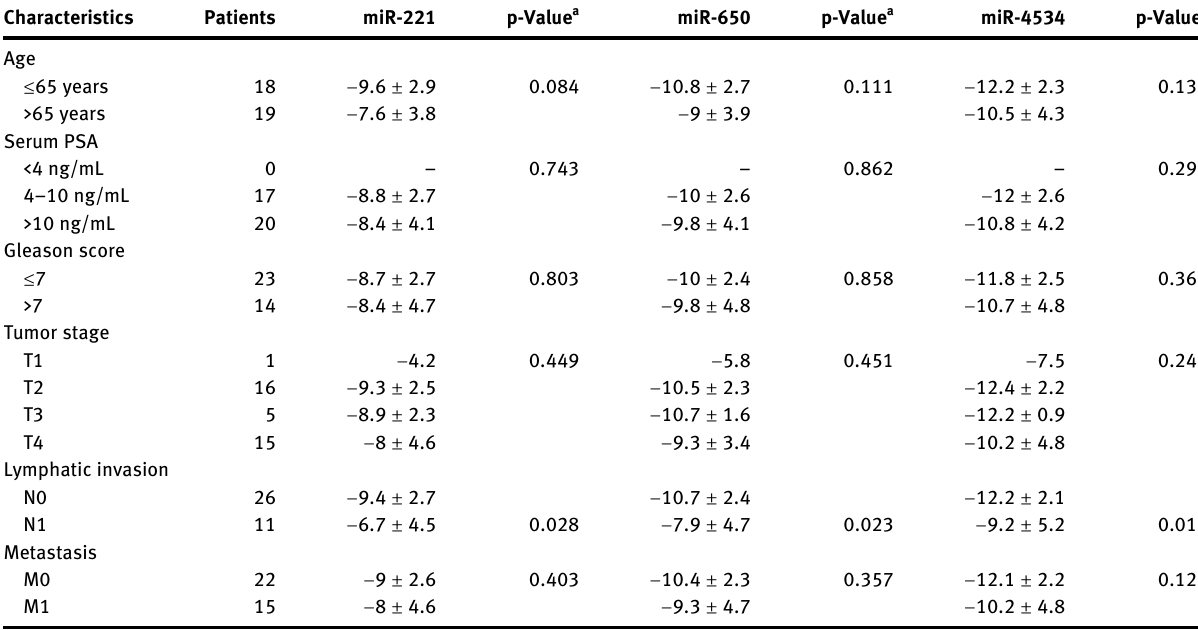
Table  : Relationship between clinical characteristics and miRNA expression levels of PCa patients. Characteristics